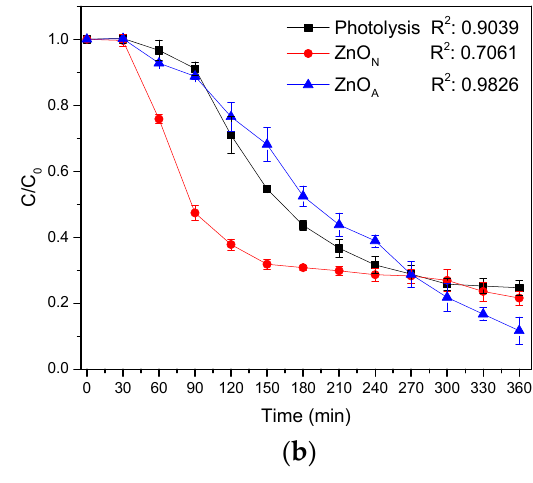
Figure 8. Degradation activities: 2,4-D ( a ) and 2,4-DCP ( b ). Table 3. Percentage of degradation after 6 h f reaction.